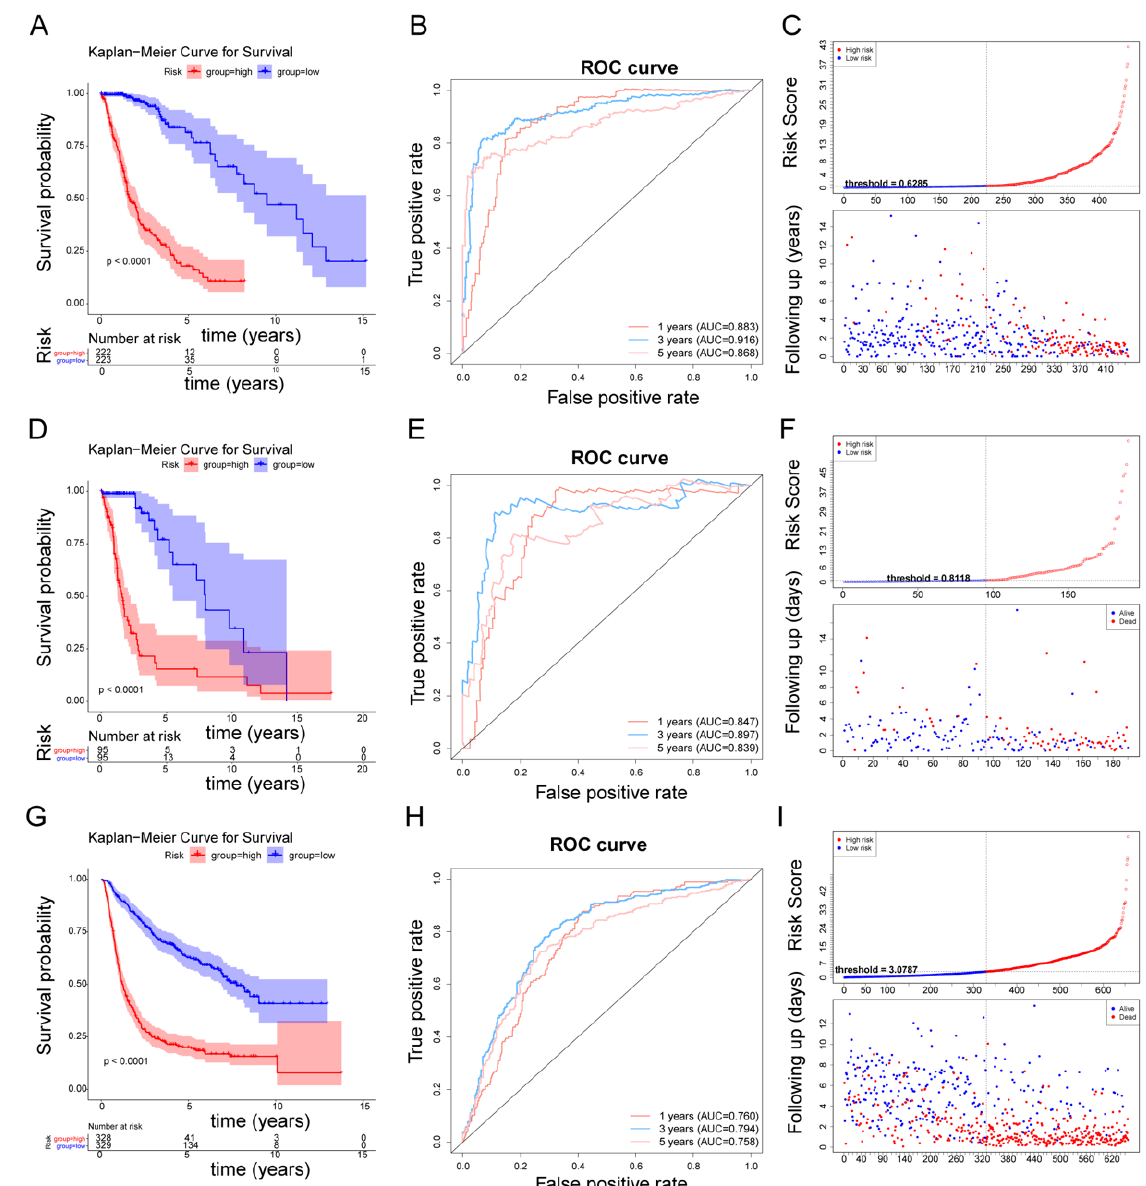
Figure 3. Construction and validation of the fibroblast-related risk score model: ( A ) Kaplan–Meier survival curve of high- and low-risk groups in the training cohort; ( B ) ROC curve of 1, 3, and 5 years in the training cohort; ( C ) risk curve of the high- and low-risk groups in the training cohort; ( D ) Kaplan–Meier survival curve of the high- and low-risk groups in the testing cohort; ( E ) ROC curve of 1, 3, and 5 years in the testing cohort; ( F ) risk curve of the high- and low-risk groups in the testing cohort; ( G ) Kaplan–Meier survival curve of the high- and low-risk groups in the validation cohort; ( H ) ROC curve of 1, 3, and 5 years in the validation cohort; and ( I ) risk curve of the high- and low-risk groups in the validation cohort.